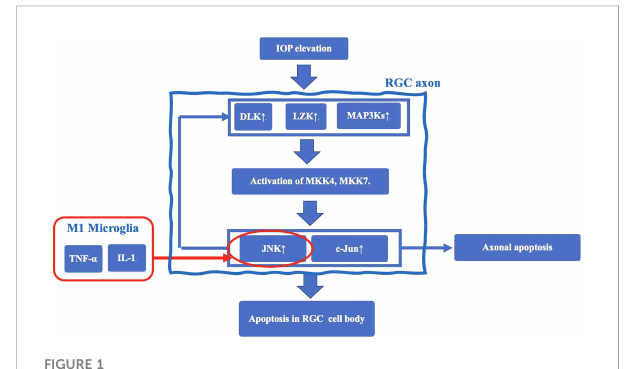
FIGURE 1 The mechanisms underlying RGC axonal injury by microglia. Elevated IOP induces expression of dual leucine zipper kinase (DLK), leucine zipper bearing kinase (LZK), and MAP3Ks, and activates MKK4 and MKK7 in RGC axons. This cascade results in upregulation of c-Jun N-terminal kinase (JNK) and the transcription factor c-Jun. JNK is an important mechanism of retrograde RGC injury. JNK is also activated by TNF- a and IL-1 released from M1 microglia to induce RGC